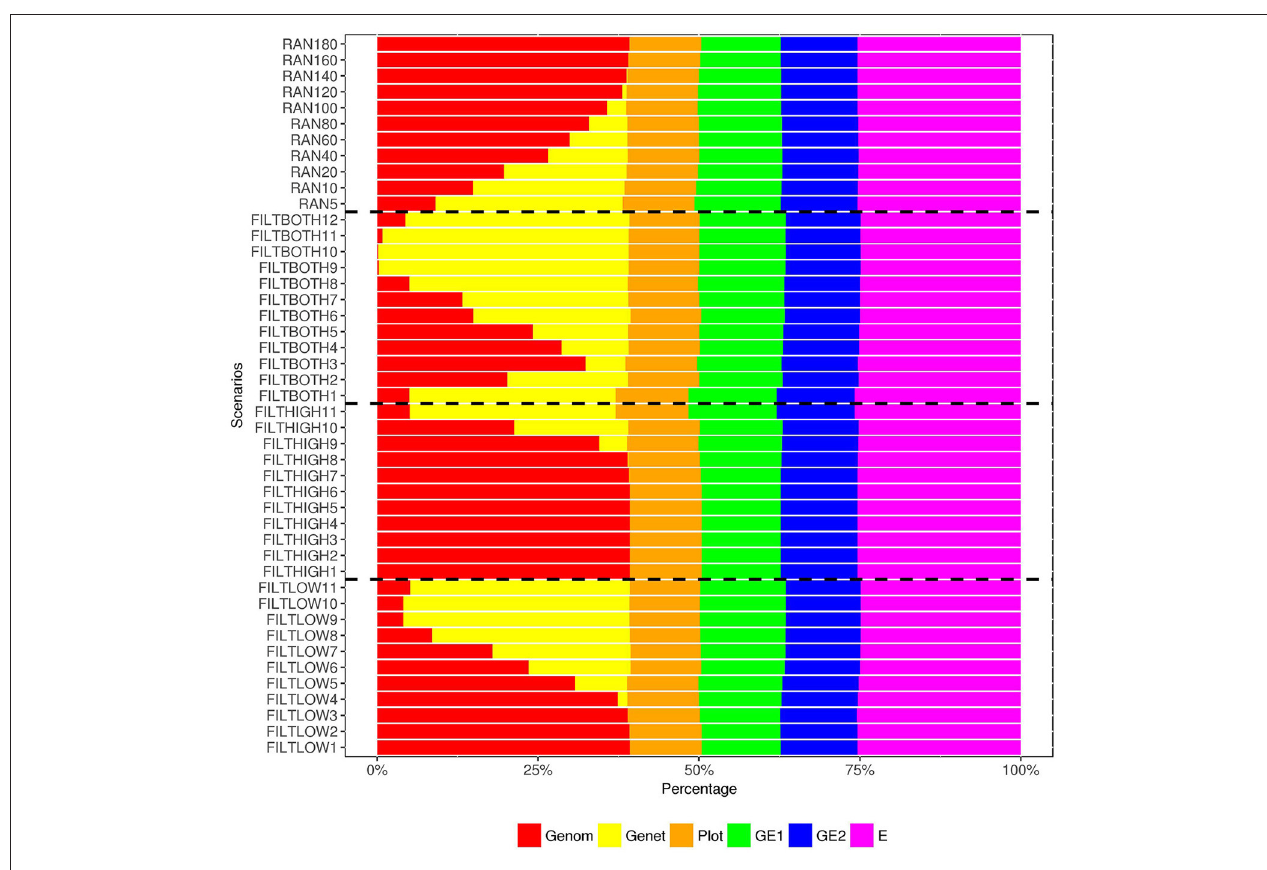
FIGURE 8 | Percentage of variance components 1 over the total phenotypic variance for rust resistance. 1 Genom, Additive genomic variance; Gene, Residual genetic variance; PLOT, random plot variance; GE1, family × sowing year × location × management variance; GE2, family × sowing year × location × management × farming year variance; E, residual environment